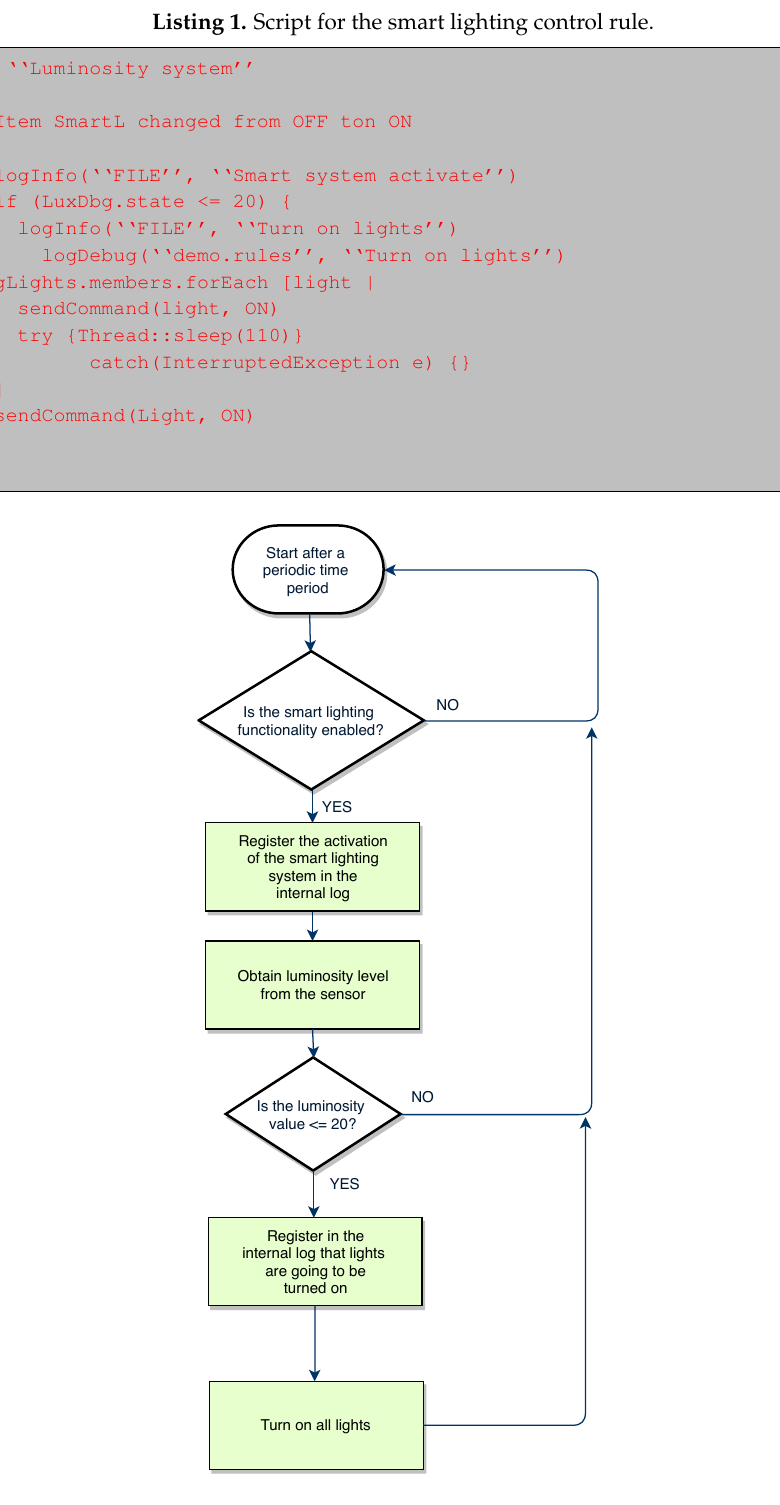
Figure 13. Flow diagram of the simplified IFTTT smart lighting